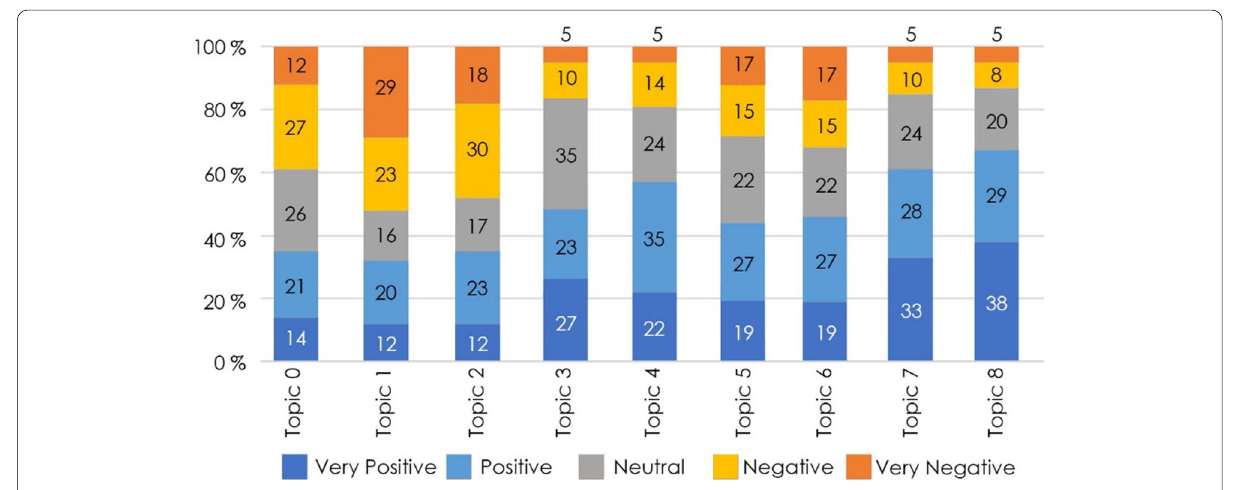
Fig. 5 Sentiment classification. Source: